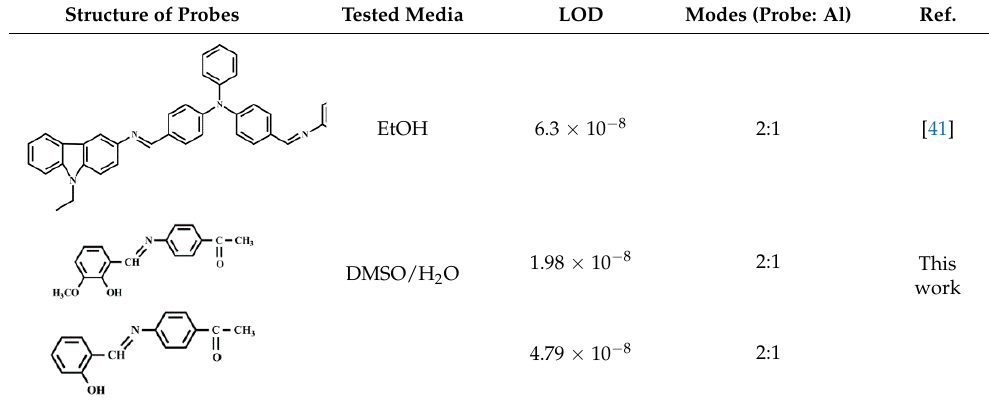
Table 1. Cont. Structure of Probes Tested Media